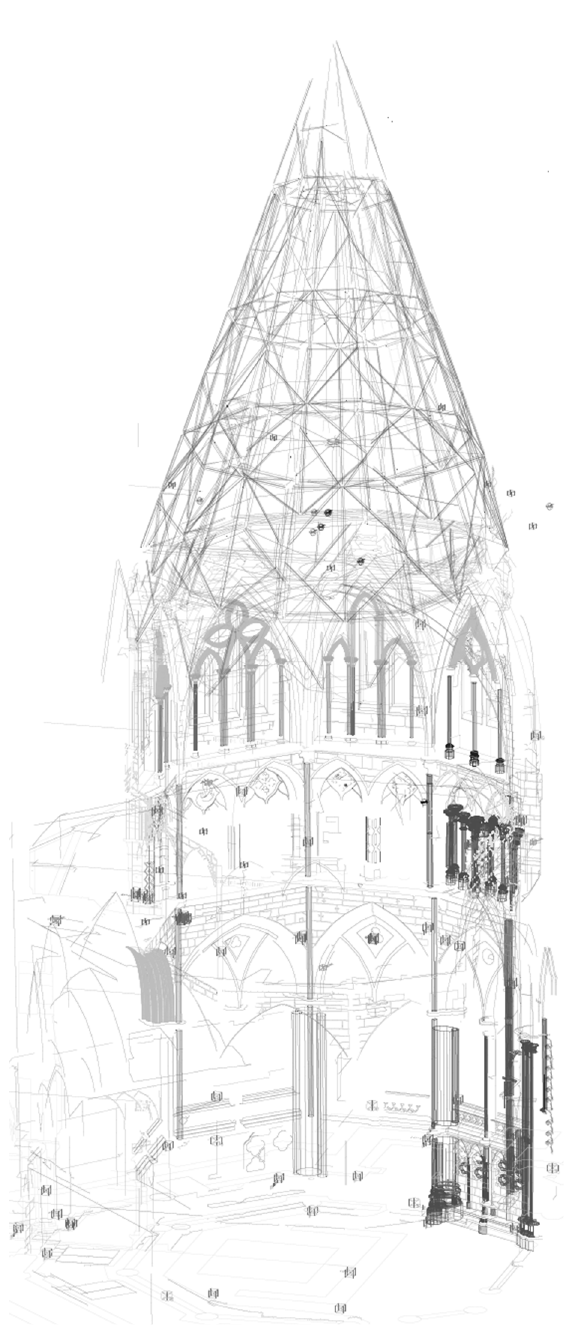
Figure 5. Tacheometrical measurement of the spire over the Octagon (Menargues Rajadell, 2014) merged with the 3D- tacheometrical Model (Breitling et al., 1999 –